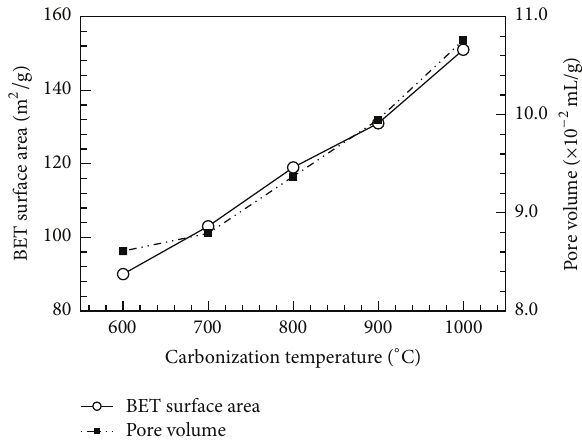
Figure 8: BET surface area and pore volume as functions of carbonization